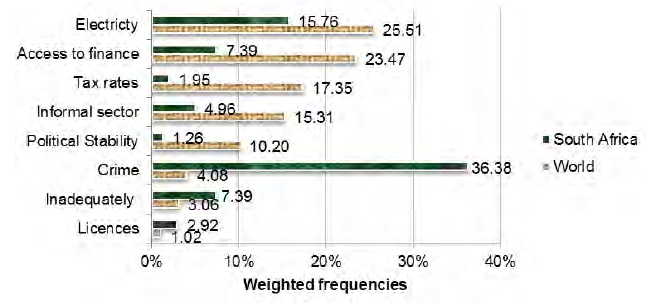
Figure 2: Top constraints reported by enterprises – South Africa versus the World Source: Dihn et al. (2010: 10); World Bank Enterprise Survey of South Africa